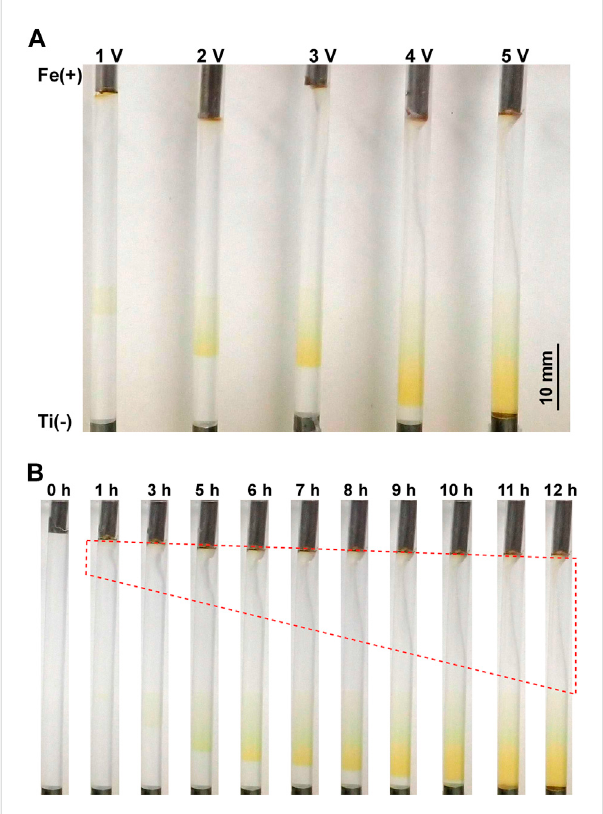
FIGURE 2 (A) Precipitation patterns formed in the gel columns with L = 50 mmat25 ° Cundertheappliedconstantvoltagesof1,2,3,4,and5 V for 12 h. Thecharges oftheelectrodes andascale barare provided on the left and right of the image, respectively. (B) Spatiotemporal evolution of the precipitation band formed at 25 ° C under an applied constant voltage of 5 V. The elapsed time after the application of voltage is indicated at the top of each image. The red broken line encloses the area where the gel column is